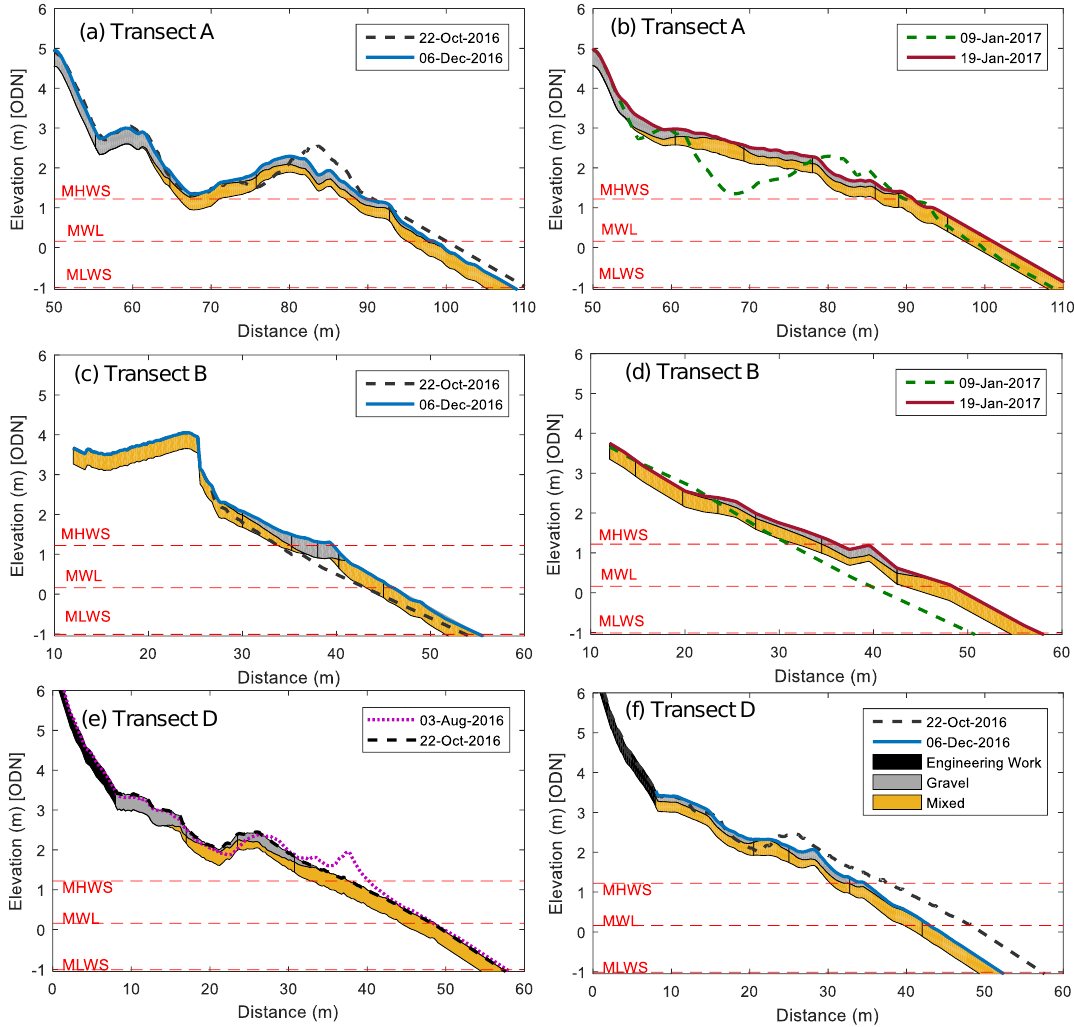
Figure 6. Examples of changes in beach morphology at ( a , b ) Transects A, ( c , d ) B, and ( e , f ) D at selected dates showing the presence of gravel (grey shading) and mixed sand and gravel (orange) deposits (within the upper 40